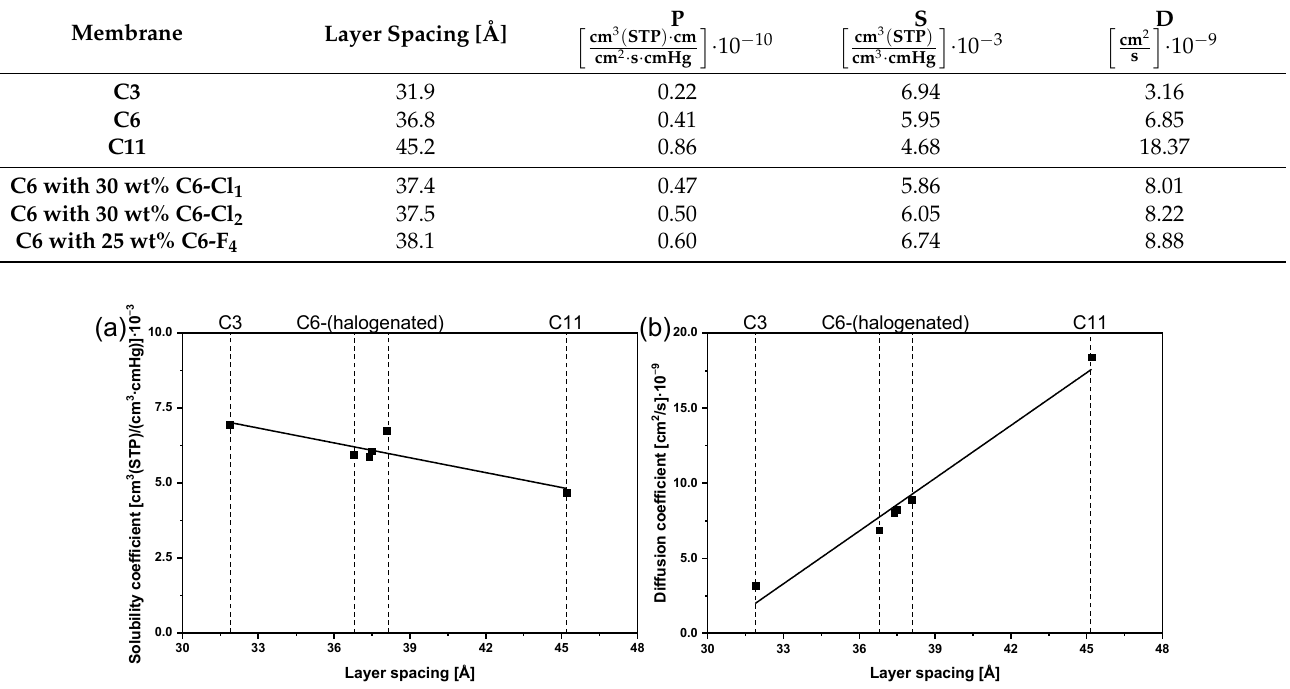
Figure 5. Effect of layer spacing on the CO 2 ( a ) solubility coefficient ( b ) and diffusion coefficient in smectic LC membranes.